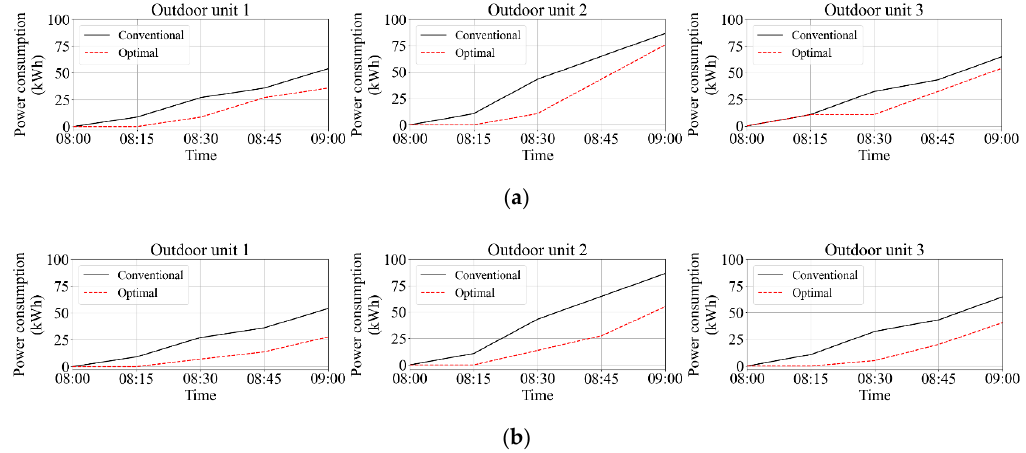
Figure 8. Energy savings with the optimal control strategy. ( a ) Comparison between conventional and optimal control (day 4); ( b ) comparison between conventional and optimal control (day